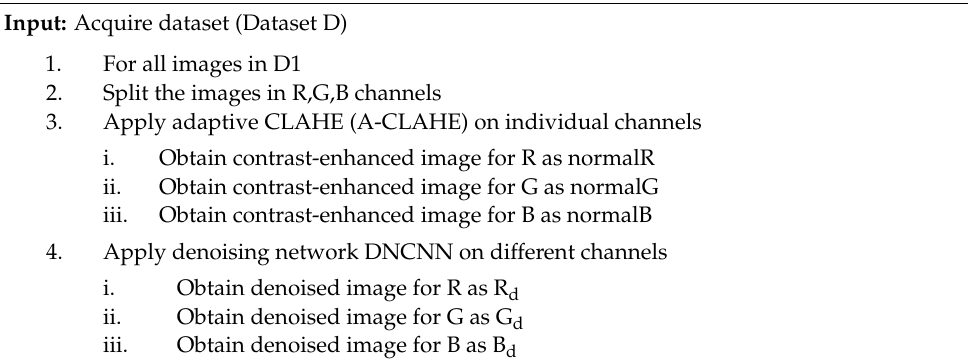
Algorithm 1: Algorithm of Pre-processing